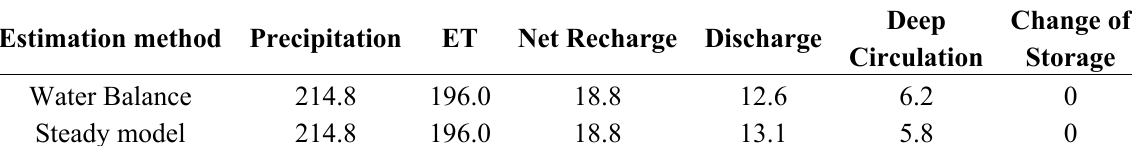
Table 3. Annual water balance estimation in the Bulang catchment in mm/year.